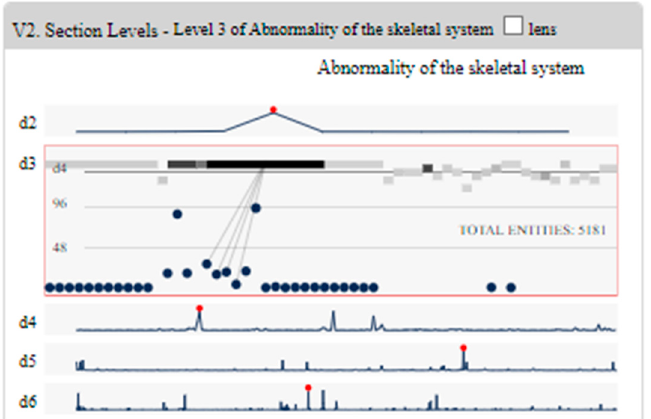
Figure 14. A level within the Ontology Section Levels Panel. The level has three main